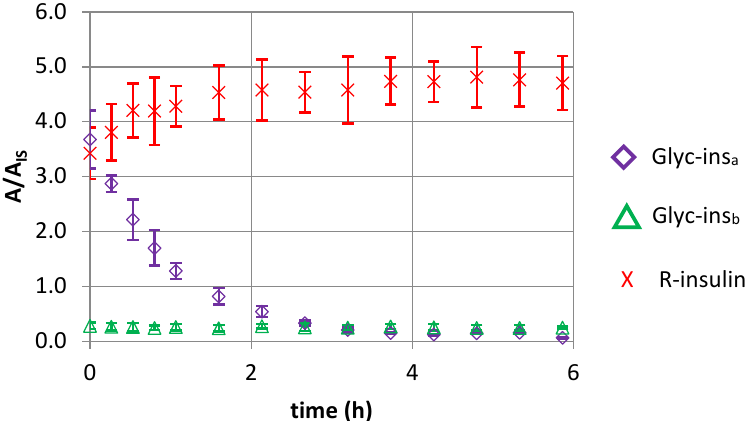
Figure 6. The change over time in the analyzed compound/internal standard area ratio (A/A IS ) reflecting the concentration of glycated R-insulins (purple diamonds, Glyc-ins a , eluted at 5.67 min; green triangles, Glyc-ins b , eluted at 5.86 min) and R-insulin (red crosses) after acidic dilution of a solution of R-insulin in 5% dextrose 24 h after its preparation (incubation at 40 °C). When the solution was diluted with a neutral IS solution, the concentrations of R- insulin and glycated R-insulin did not change significantly.